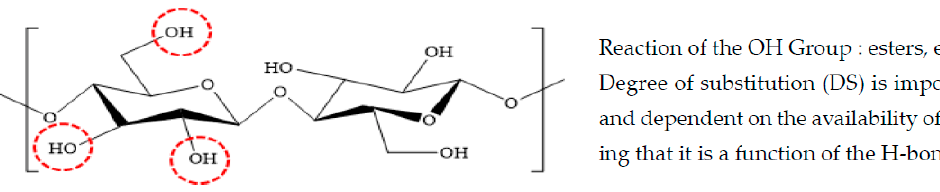
Figure 4. Structure of Cellulose.